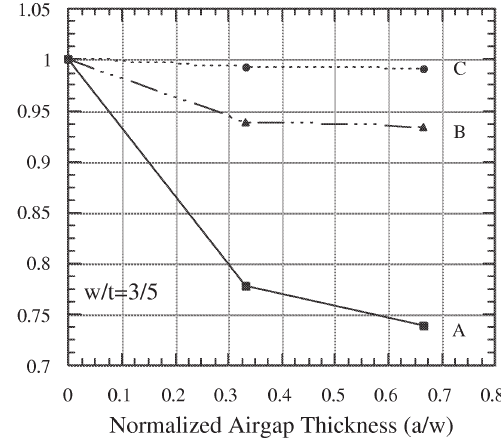
Fig. 9. Calculated peak pressures of non-contact watershield normal- ized by the peak pressure of no watershield, w=t = 2